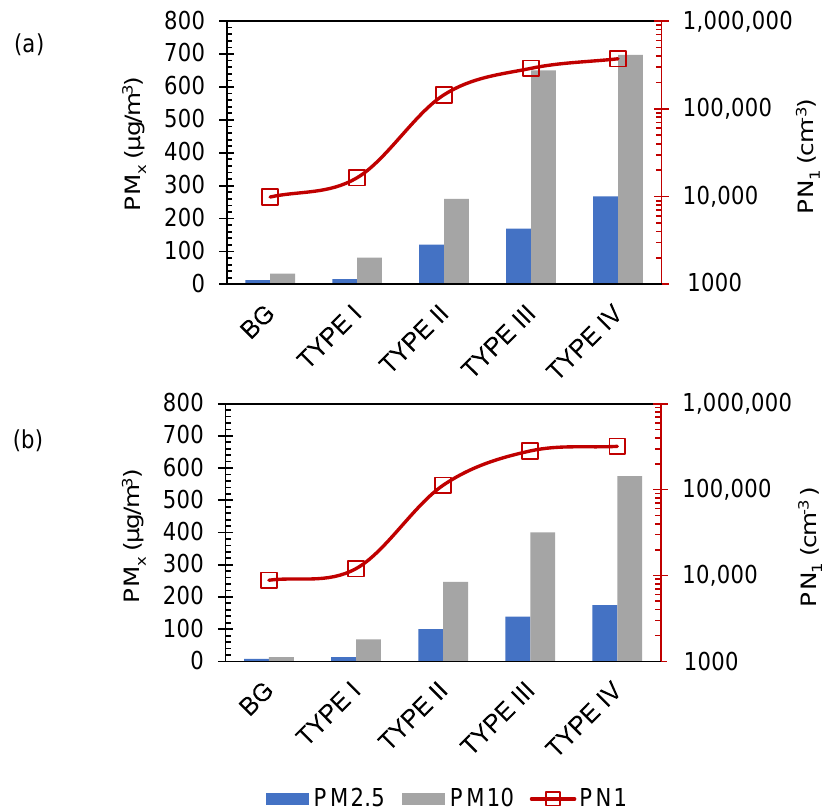
− 3 16,400 ± 17,200 cm and the corresponding PM 2.5 and PM 10 concentrations were 16 ± 11 µ g / m 3 and 82 ± 53 µ g / m 3 , respectively. This was slightly higher than the overall mean background concentrations − 3 for all homes with PN = 9900 ± 4900 cm , PM 2.5 = 13 ± 15 µ g / m 3 , and PM 10 = 33 ± 53 µ g / m 3 .